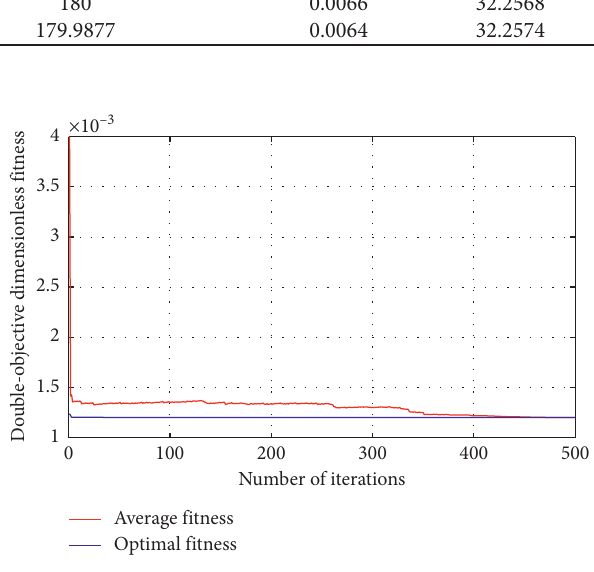
Figure 7: The convergence progress of the double-objective op- timization for the coaxiality and unbalance.